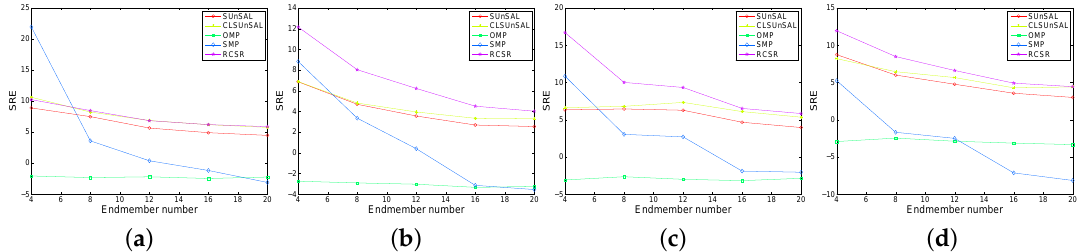
Figure 6. Performance of SRE as a function of the number of endmembers under correlated noise when the SNR is 50 with the ( a ) LMM; ( b ) FM; ( c ) GBM and ( d ) MGBM.